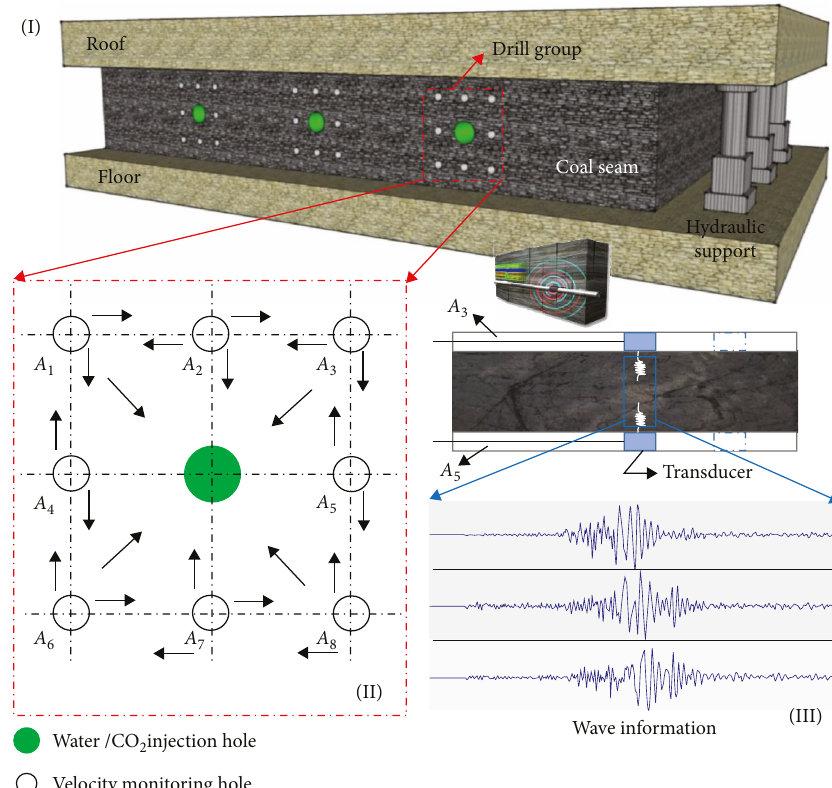
Figure 8: Potential application of velocity measurements by hydraulic fracturing or CO